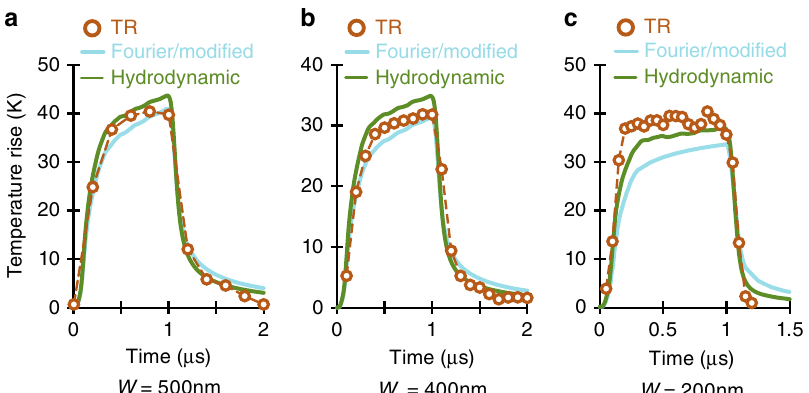
Fig. 4 Temporal failure of modi fi ed Fourier theory. Transient responses for small devices with line widths of a 500 nm, b 400 nm and c 200 nm. Finite element Fourier model (grey lines) with adjusted InGaAs thermal conductivities that accurately capture the quasi-static peak temperatures of each device do not match the faster heating/cooling time constants of the experimental data. Hydrodynamic (KCM) capture better the faster transient response,